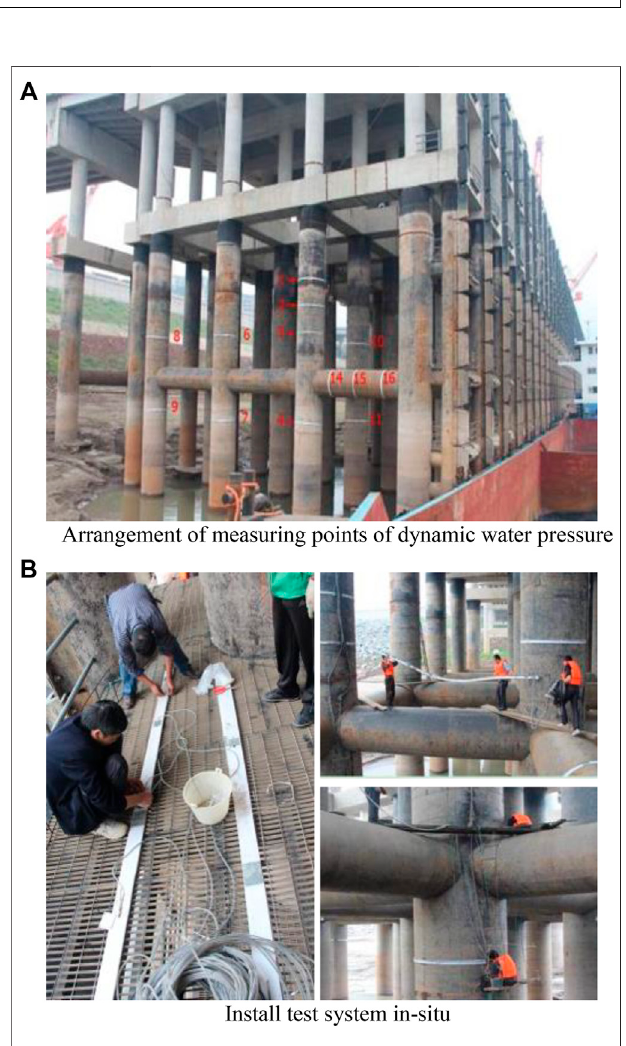
FIGURE4| In-situ test installation. (A) Arrangementofmeasuring points of dynamic water pressure (B) install test system in-situ